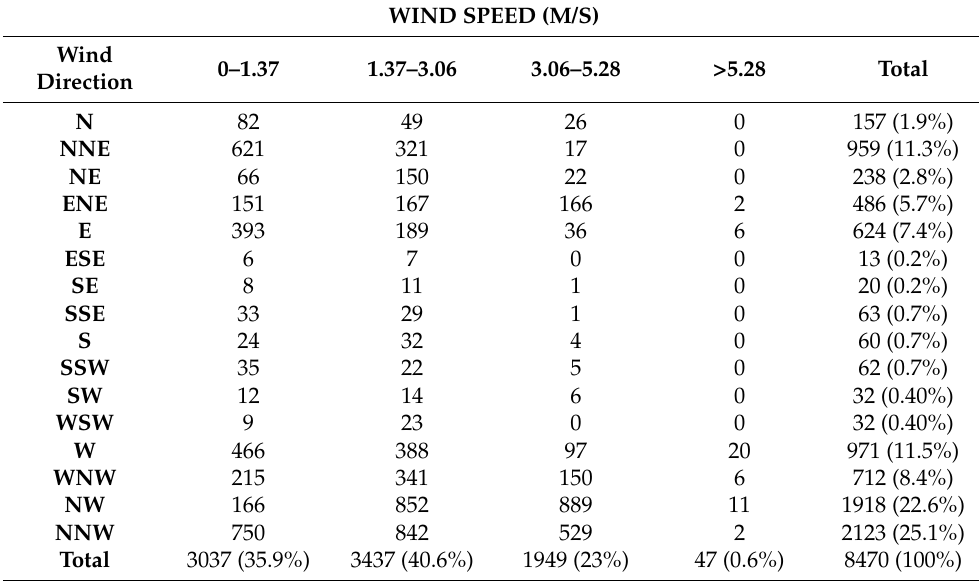
Table A2. Wind speed and direction observed during the year.